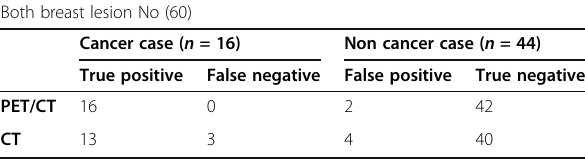
Table 2 Diagnostic performance of PET/CT and contrast- enhanced CT to detect breast lesion in both breast of 30 cases with breast cancer Both breast lesion No (60) Cancer case ( n = 16) Non cancer case ( n =